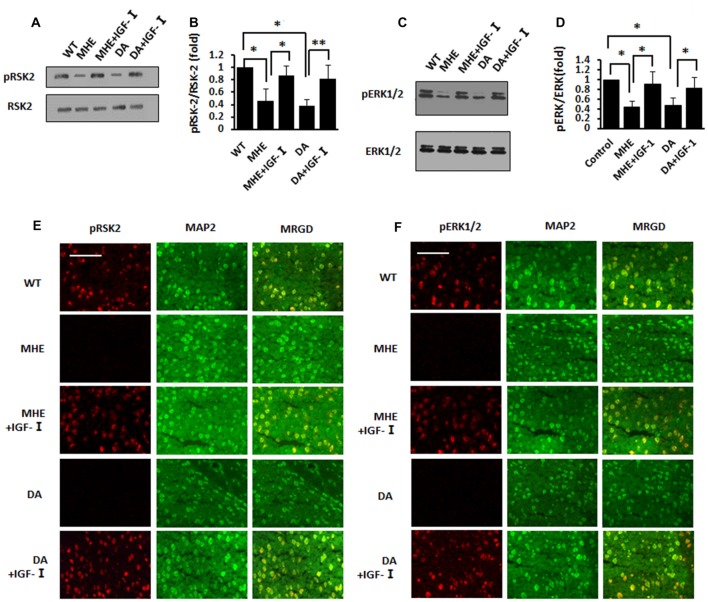
IGF-I activates ERK1/2/RSK pathway in MHE and DA-treated rats. (A,B) IB analysis of hippocampal lysates from MHE rats (n = 26) or DA-treated rats (n = 20) with or without IGF-I administration using anti-pRSK and anti-RSK antibodies and subsequent densitometry. (C) Double IF staining of brain sections from MHE rats or DA-treated rats with administration using antibodies against pRSK (red) and MAP2 (green). (D,E) IB analysis of hippocampal lysates from MHE rats or DA-treated rats with or without IGF-I administration using anti-pERK1/2 and anti-ERK1/2 antibodies and subsequent densitometry. (F) Double IF staining of brain sections from MHE rats or DA-treated rats with or without IGF-I administration using antibodies against pERK1/2 (red) and MAP2 (green). Data are shown as mean ± SD. *P < 0.05, **P < 0.01. Scale bar, 25 μm. MRGD, merged image.